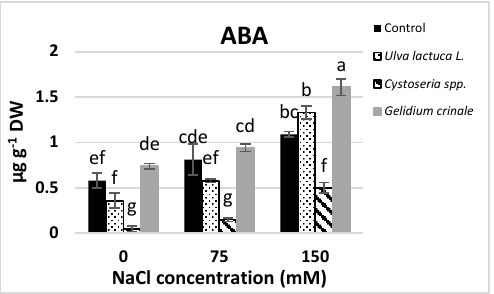
Figure 2. The impact of Ulva lactuca L., Cystoseria spp., and Gelidium crinale soil treatment on endogenous phytohormones (IAA, IBA, GA 3 , Z, BA, ABA, and JA) of the canola shoot apex (at the vegetative stage) grown under different levels of salinity. Data are presented as the mean ± SD ( n = 15). Different letters indicate significant differences based on a comparison of means with Duncan’s multiple range test at p < 0.05.